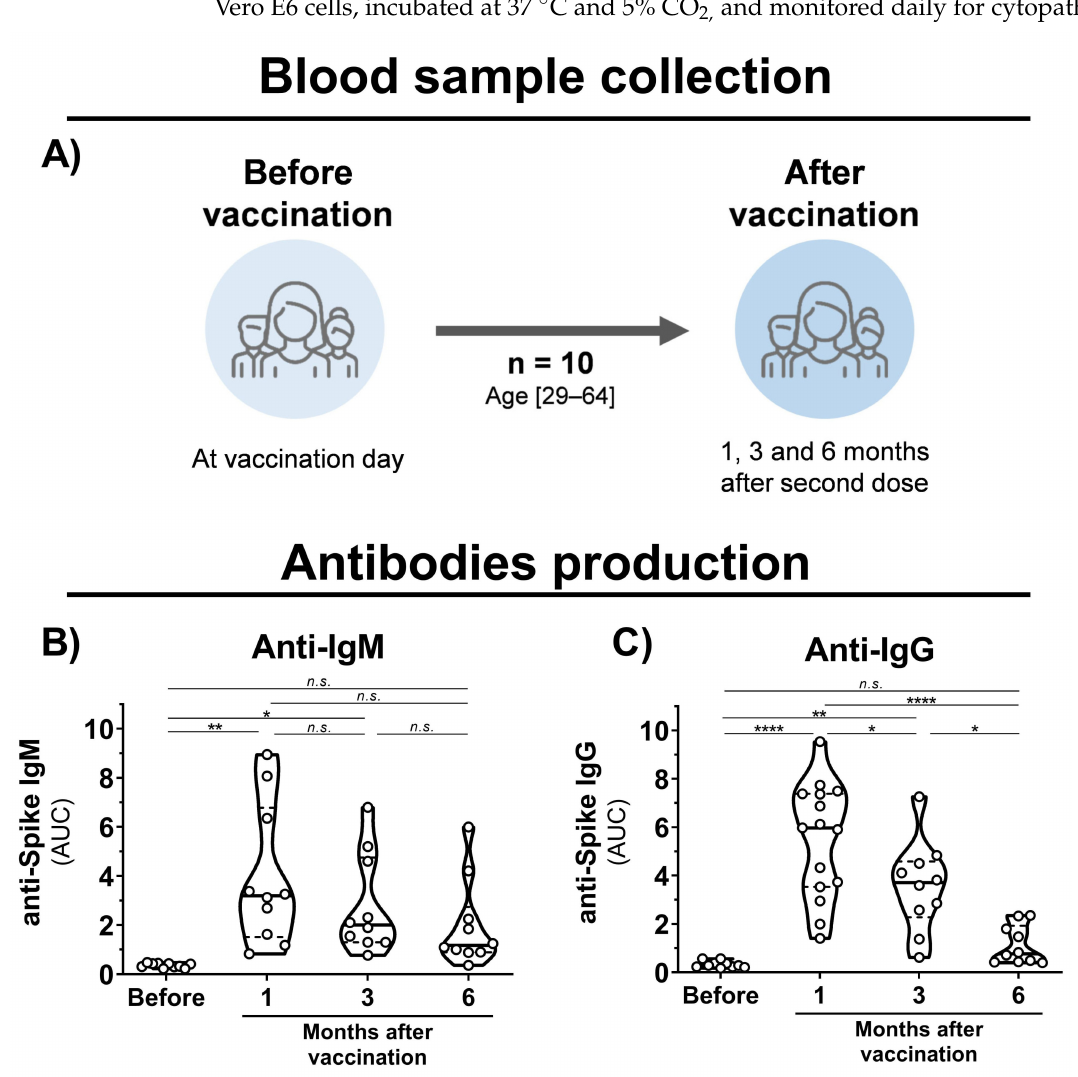
Figure 1. Blood sample collection time points and antibody production in CoronaVac-vaccinated individuals. ( A ) Schematic representation of established cohort and sample collection. ( B , C ) Violin plots showing anti-S IgM and IgG levels, respectively, of vaccinated individuals before vaccination and after 1, 3, and 6 months of the second dose. Multiple comparisons were performed by one-way ANOVA with post hoc Tukey’s test. * p < 0.05; ** p < 0.001; **** p < 0.0001. AUC = area under curve; n.s. = not statistically significant; IgG = immunoglobulin